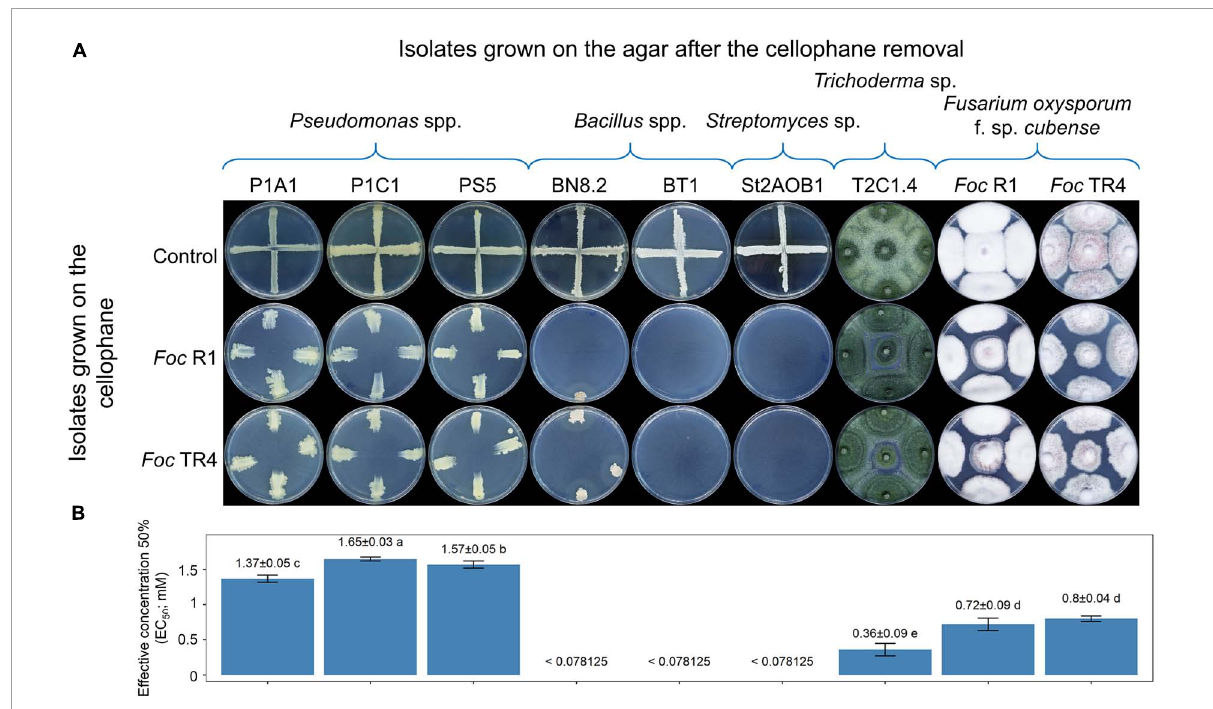
FIGURE6 Effect of Fusarium oxysporum f. sp. cubense ( Foc ) on the growth of SynCom 1.1 isolates. Effect of Foc race 1 (R1) or tropical race 4 (TR4) metabolites in the cellophane-agar method (A) and determination of the effective doses of commercial fusaric acid (B) . In (A) , on the rows, isolates grown on the cellophane before its removal (viz. producing putatively toxic metabolites) are indicated. On the columns, isolates inoculated in the plates after cellophane removal (viz. isolates targeted by the metabolites) are indicated. Partial growth or null growth is indicative of sensitivity to metabolites released in the medium. Each plate is representative of four replicates. In (B) , bars indicate standard error ( n = 3). Means with different letters are significantly different according to Tukey’s test ( P <